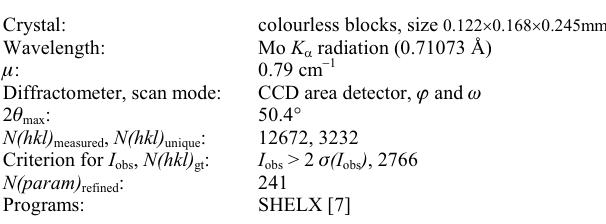
Table 2. Atomic coordinates and displacement parameters (in Å 2 )